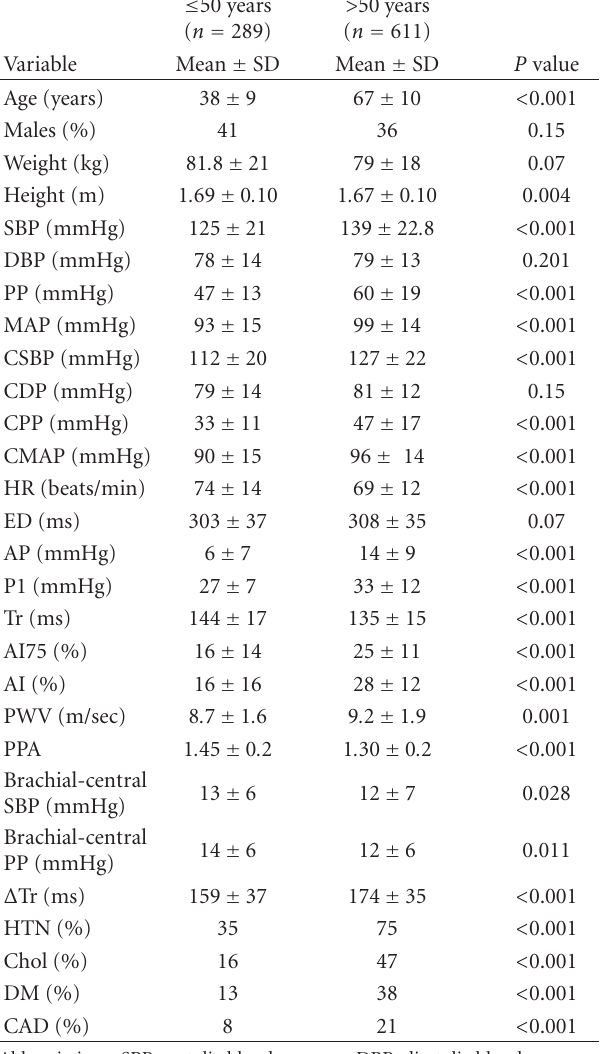
Table 1: Clinical and hemodynamic characteristics of the study